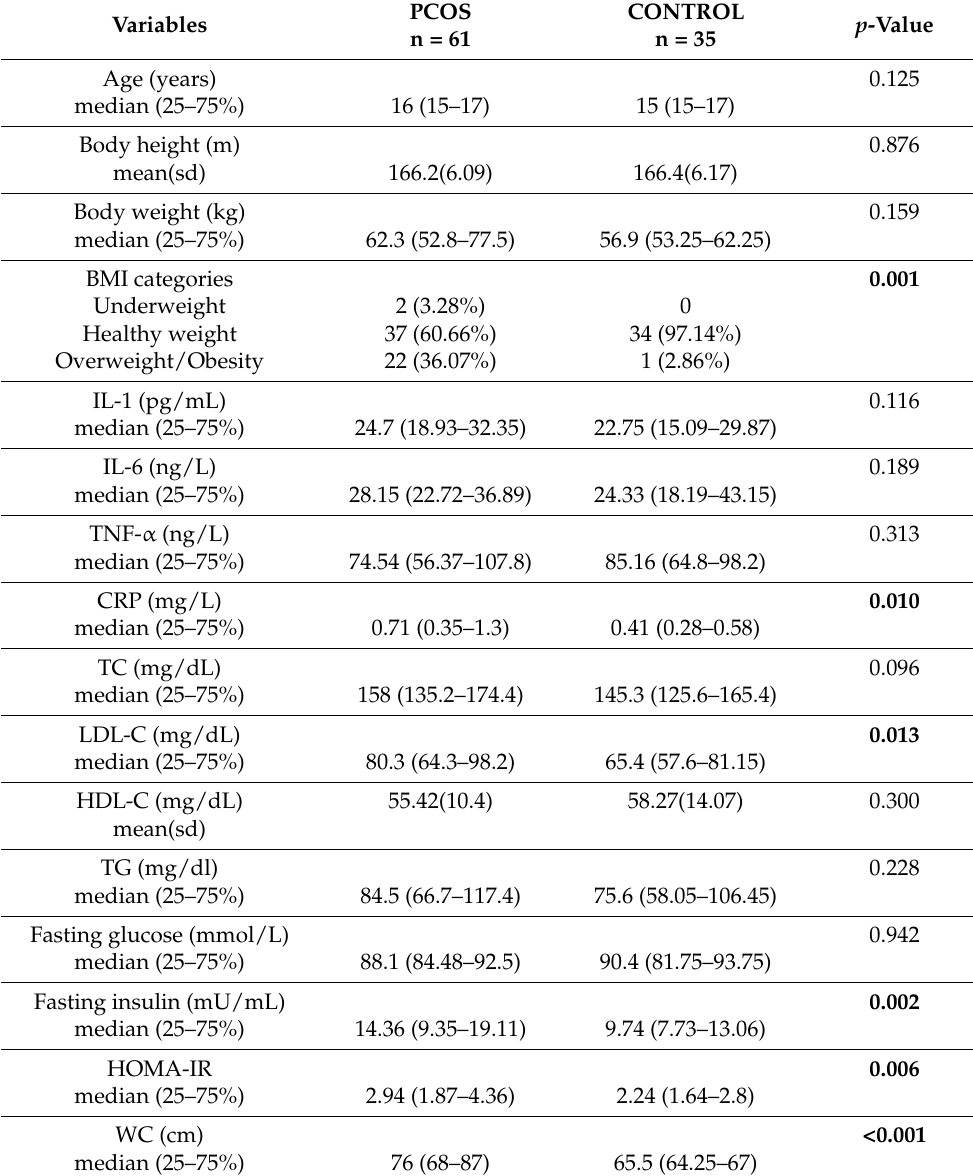
Table 1. Anthropometric, metabolic, inflammatory markers and PA comparison between PCOS group (PCOS) and control group